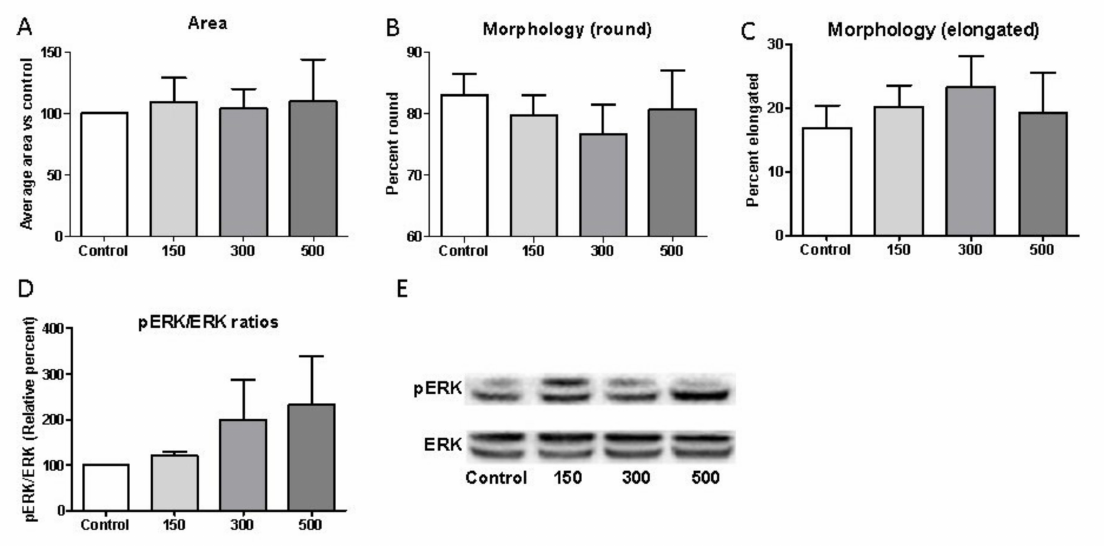
Figure 7. Shockwave treatment alters macrophage morphology and activates ERK signaling. J774 macrophages were exposed to shockwave intensities of 150–500; 5 Hz, 0.1 mJ/mm 2 or left unstimulated (control). ( A ) Cell area and ( B ) changes in the percentage of J774 macrophages with rounded morphology and ( C ) elongated morphology as determined by aspect ratios; mean values ± SEM; n = 4 independent experiments; average 100 cells analyzed per preparation. ( D ) Shockwave stimulation induces ERK phosphorylation. ( E ) Representative Western blot for pERK and total ERK 30 min post-shockwave stimulation. Quiescent J774 cells were stimulated with shockwaves for 30 min. Total cell lysates were subjected to SDS-PAGE. Phospho-ERK mAbs were used to detect the active form of the kinase. The same blots were re-probed with antibodies against total ERK as loading controls. Quantification of protein phosphorylation levels was performed by scanning densitometry and presented as percentage increase above control non-exposed levels (mean ± SEM, n =